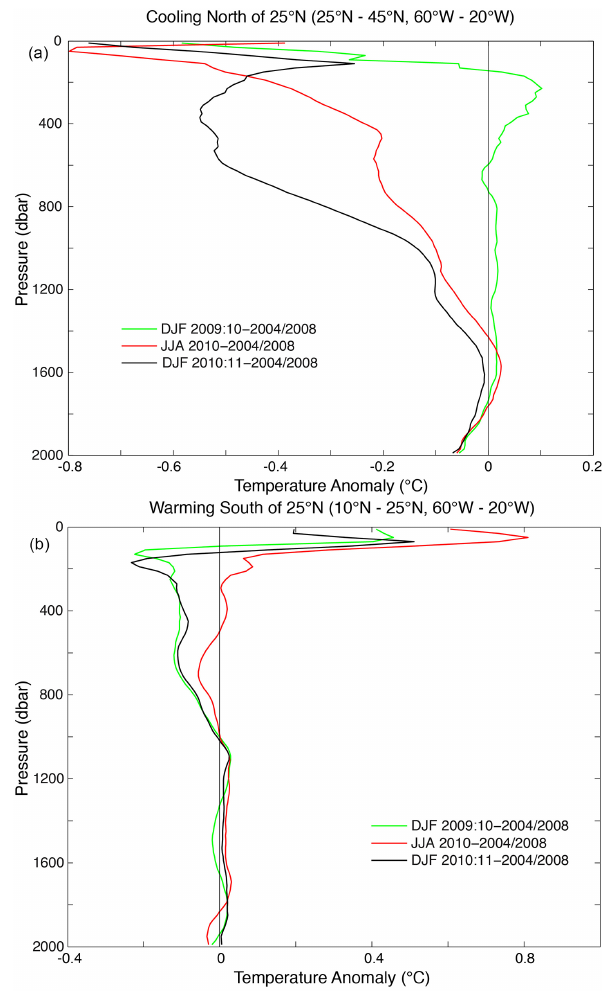
Figure 5. Vertical structure of temperature change (a) north and (b) south of 25 ◦ N during winter (DJF) 2009–2010, summer (JJA) 2010 and winter (DJF) 2010–2011. The temperature change is estimated as the difference from the average vertical temperature profiles for the period April 2004 to December 2008 in the north and in the